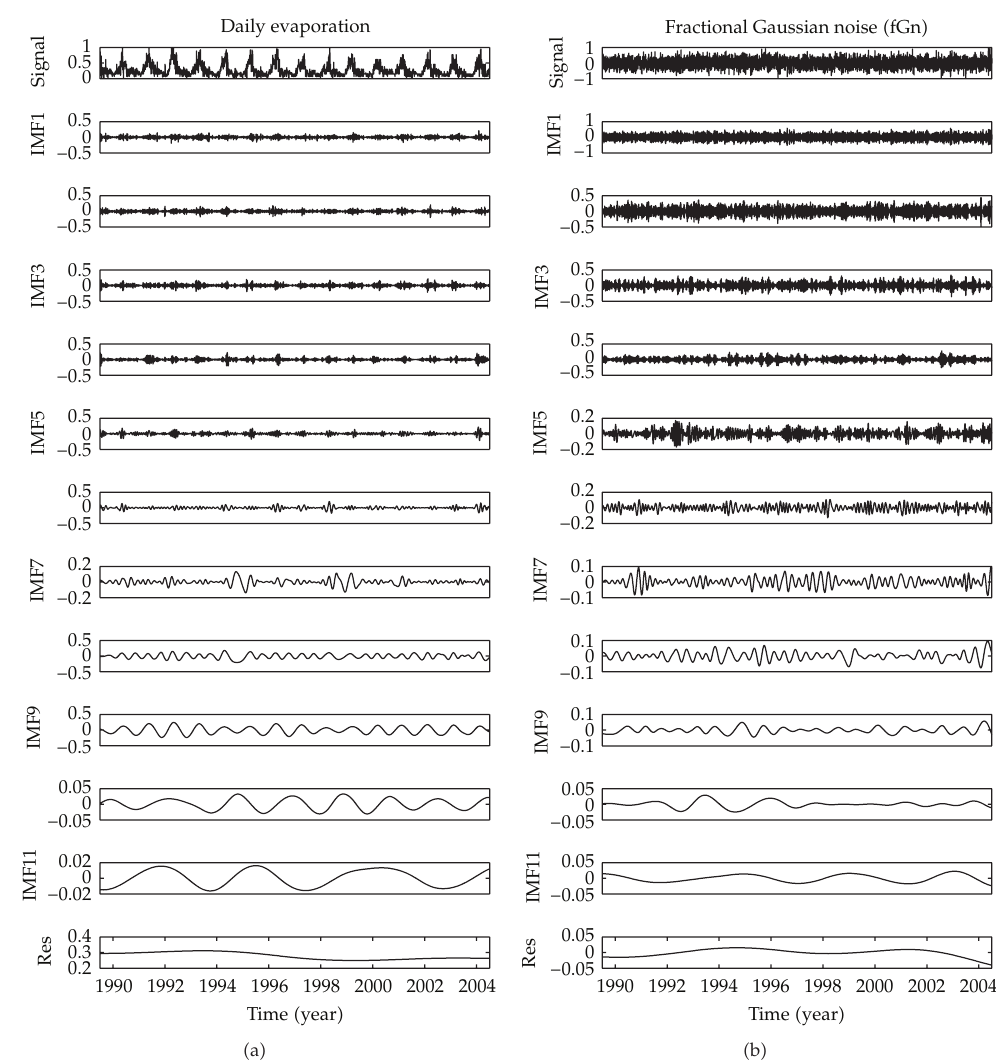
Figure 1: BEMD of climate signal (cid:2) daily evaporation (cid:3) associated with the fGn. The left and right columns represent the IMFs corresponding to climate signals (cid:2) daily evaporation (cid:3) and fGn, respectively.